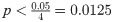
SNP distribution in the flanking region of the coding start site (CSS).SNP pattern in the flanking region (–15 to +13) of canonical and alternative starts. The applied permutation test provided the following p-values (curves from top to bottom): RefSeq+1000G: 0.0, RefSeq+GoNL: 0.0002, HEK293+1000G: 0.027, HEK293+GoNL: 0.244. With a significance threshold of p<0.054=0.0125, the drop in the total number of SNPs at the CSS is significant only for canonical start sites. Upper panel: total number of SNPs; Lower panel: the number of SNPs normalized by the number of sequence contexts with at least one SNP, compare with Table 1.